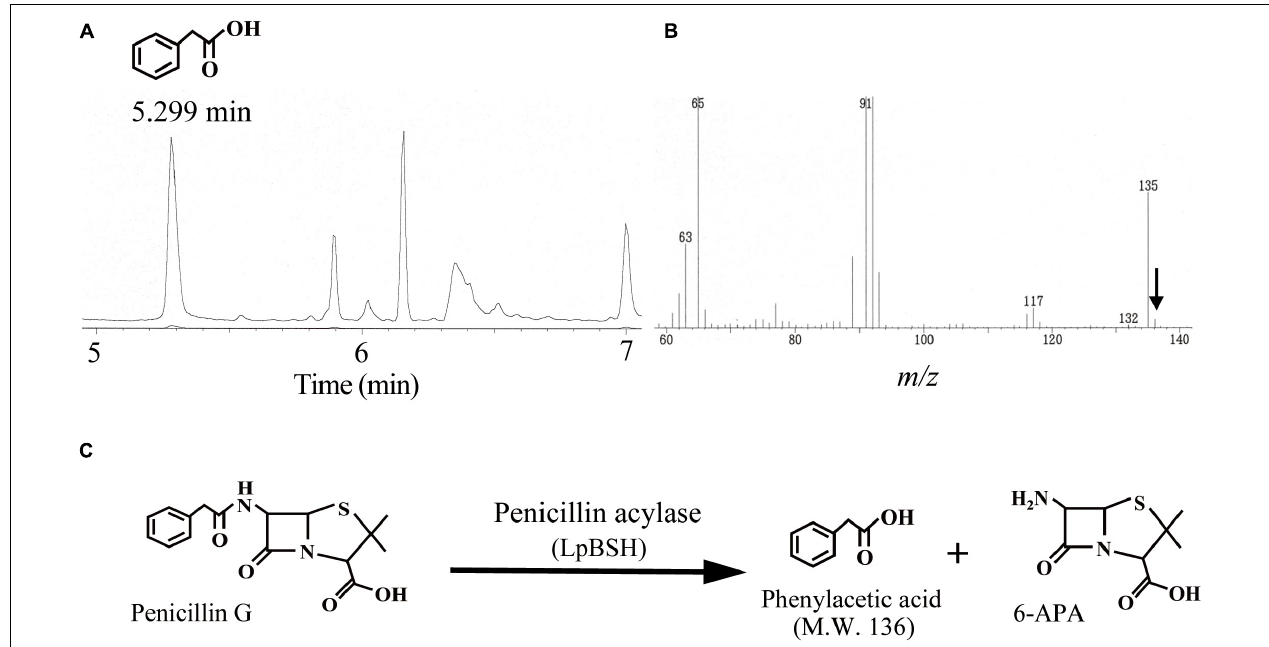
FIGURE 3 | Gas chromatography-mass spectrometry analyses of penicillin G degradation products by LpBSH. Gas chromatography profile of digestion products of penicillin G by LpBSH (A) and its mass spectrometry retention times at 5.299 min (B) . The arrow indicates the parent peak ( m/z 136) of the 5.299 min GC fraction. Schematic representation of penicillin G degradation by PA activity of LpBSH (C) .